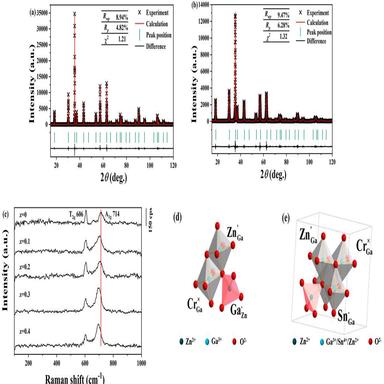
Rietveld refinement of the XRD patterns for (a) ZGSO: Cr3+ (x = 0) and (b) ZGSO: Cr3+ (x = 0.4). (c) Raman spectra of ZGSO:Cr3+ (x = 0-0.4). Schematic illustration for defect clusters arising from (d) intrinsic anti-site defect and (e) introduced anti-site-like defects.